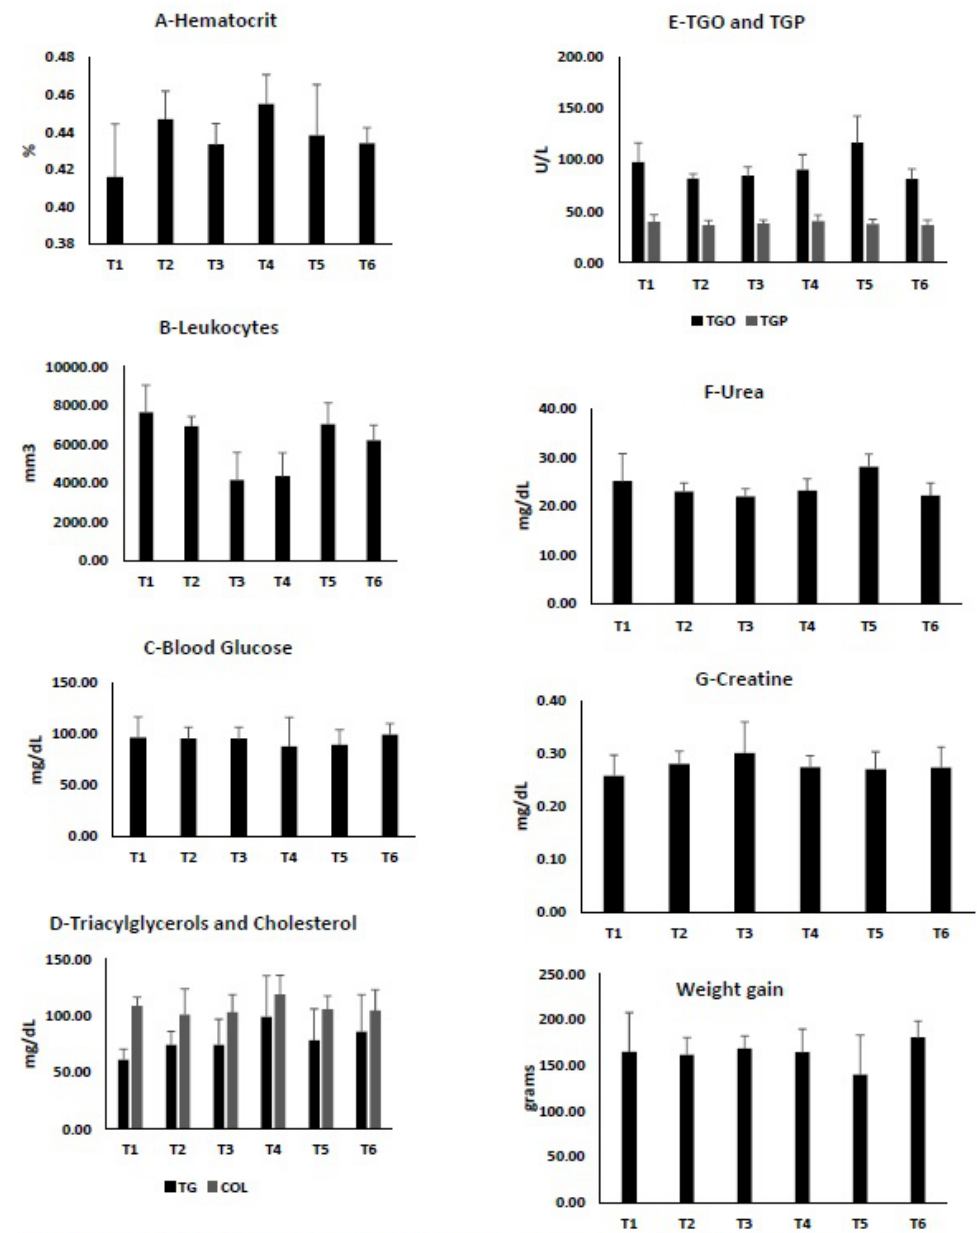
Figure 1. Biochemical results after Amazonian pulp fruits consumption in Wistar rats ( n = 10 rats/group), T1—Control; T2—Araç á -Boi; T3—Abiu-grande; T4—Araticum; T5—Biri-biri; T6—Yellow mangosteen; TGO—glutamic-oxaloacetic transaminase; TGP—glutamic-pyruvic transaminase; TG—triacylglycerol and Col—Cholesterol. Mean values and standard deviation are